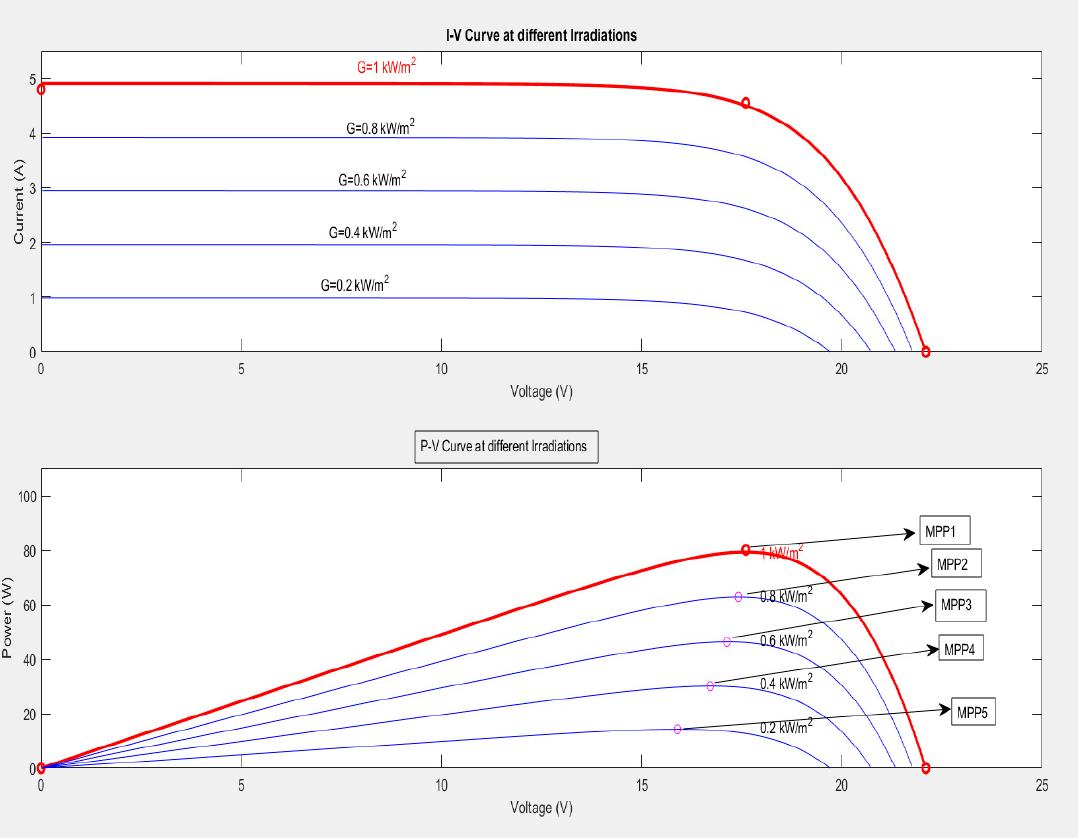
Figure 1. I–V and P–V curves of a photovoltaic (PV) module at different solar irradiation levels .